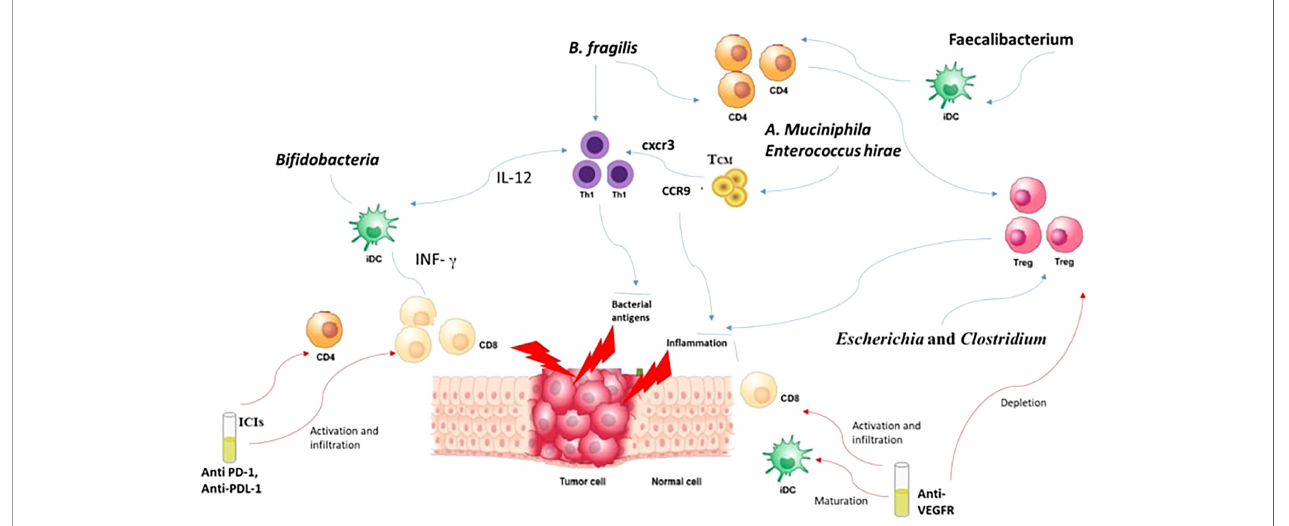
FIGURE 2 | Interaction between microbiota, CPIs and